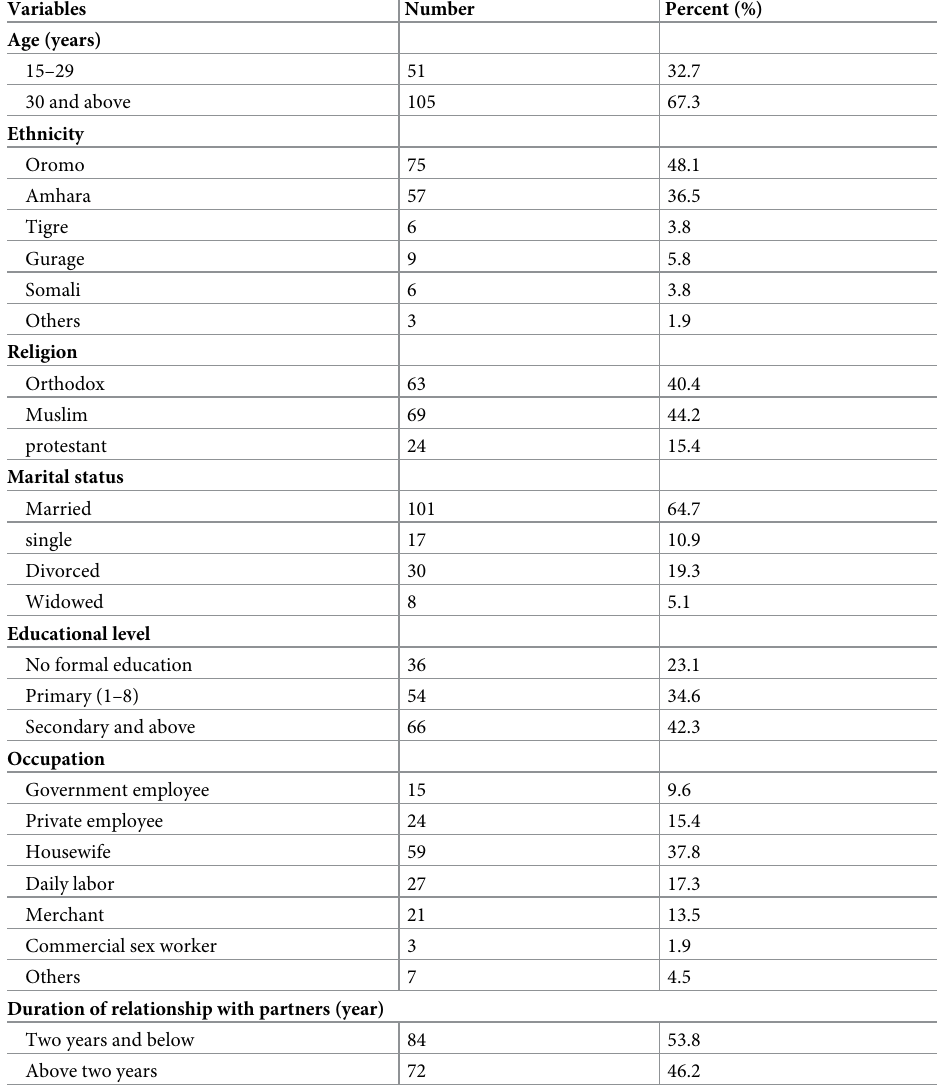
Table 1. Sociodemographic characteristics of HIV-positive pregnant women attending ANC service in public health facilities in Dire Dawa, Ethiopia, 2020, (n = 156). Variables